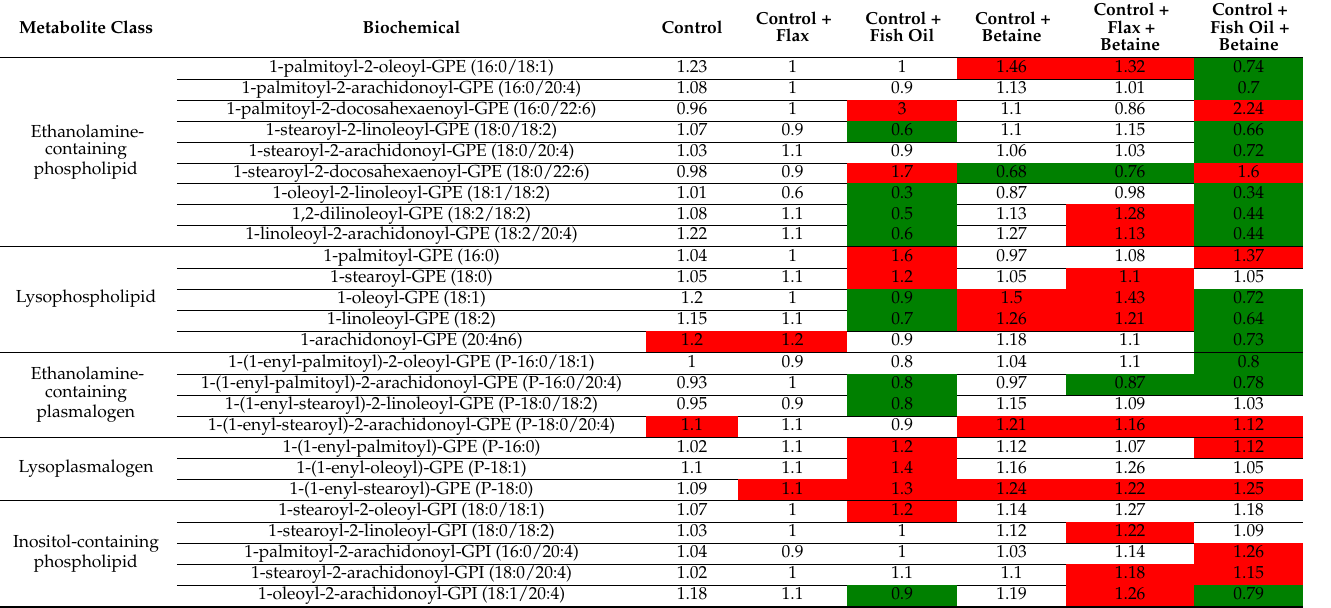
* This table consists of all analytes that had a p ≤ 0.05 and a q ≤ 0.1 for both change during the study and a difference between treatments at the end of the study. Values are change during the study while eating the